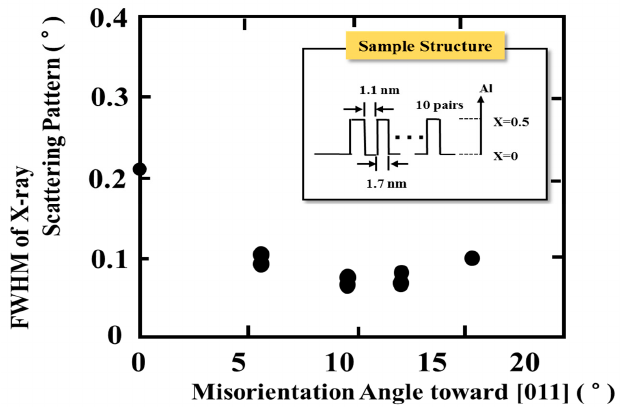
Figure 8. Relationship FWHM of the first peak in the small angle X-ray scattering pattern and misorientation angle toward [011] direction.